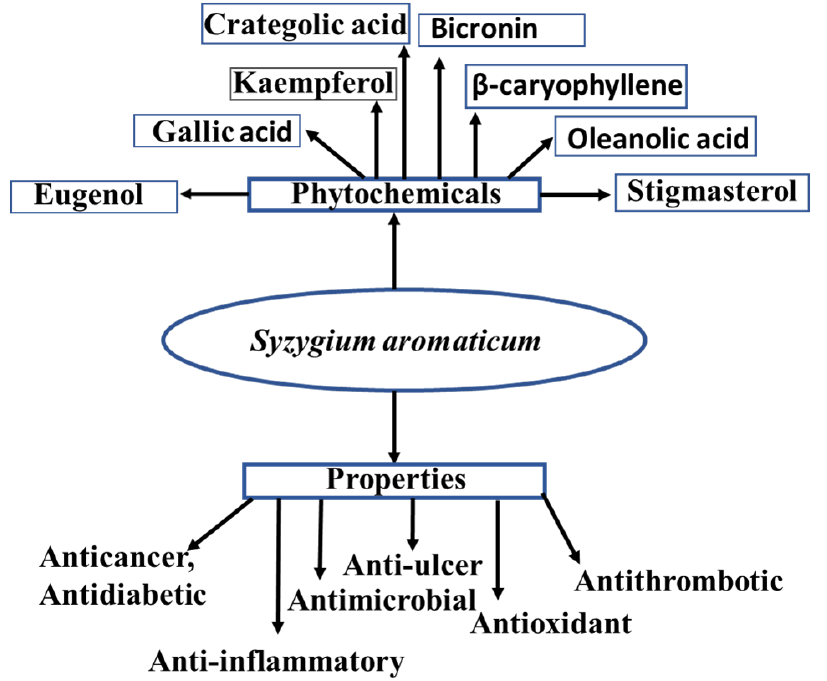
Figure 1. Phytochemical and therapeutic properties of cloves [41].